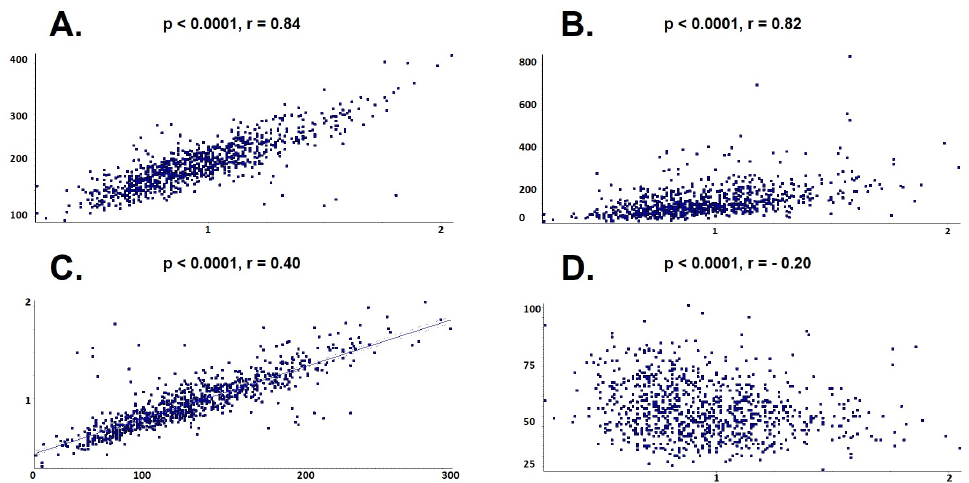
Figure 6. Univariate linear regression between Apo B and lipid profile. ( A ) Total cholesterol; ( B ) Triglycerides; ( C ) Low-density lipoprotein cholesterol; ( D ) High-density lipoprotein cholesterol . At the same time, univariate regression analysis identified a strong association between the level of uric acid and increased Apo B value, as indicated in Figure 7 (uric acid 4.8 +/− 1.3 in subgroup A, 5.0 +/− 1.6 in subgroup B, 5.1 +/− 1.5 in subgroup C and 5.8 +/− 1.6 in subgroup D, r = 0.2, p < 0.0001).